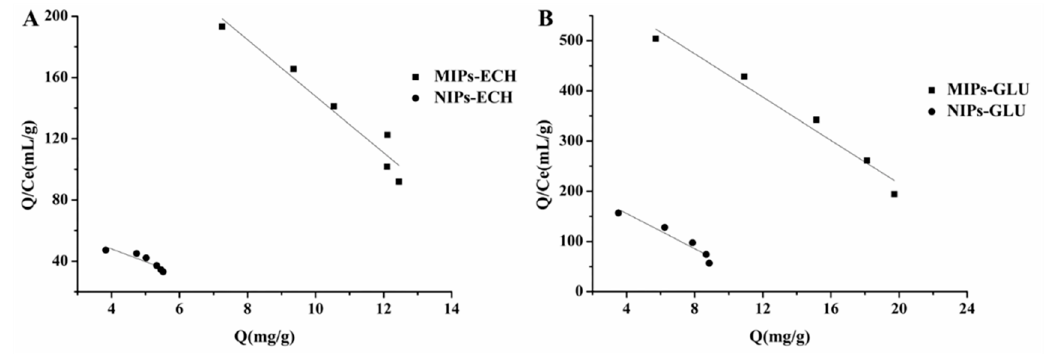
Figure 6. Scatchard plot analysis of the binding property of ALA to MIPs and NIPs. ( A )